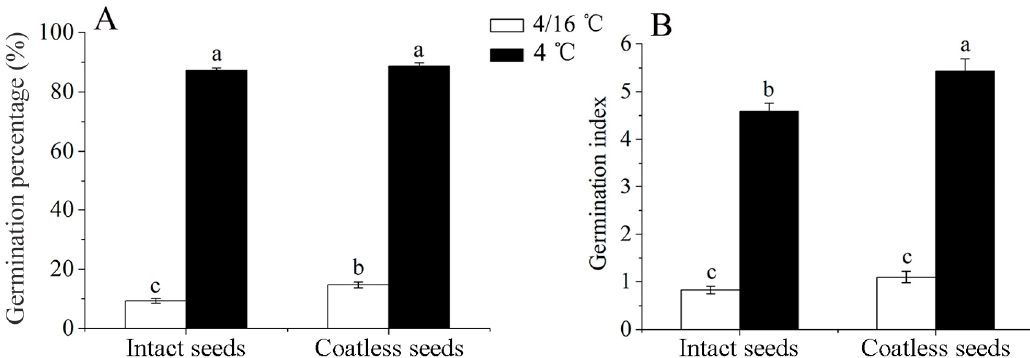
Figure 1. The germination percentage ( A ) and germination index ( B ) of intact seeds and coatless seeds of Tulipa thianschanica at a constant temperature of 4 °C and a fluctuating temperature of 4/16 °C. The different lowercase letters indicate a significant difference at p < 0.05 with Duncan’s multiple range test.